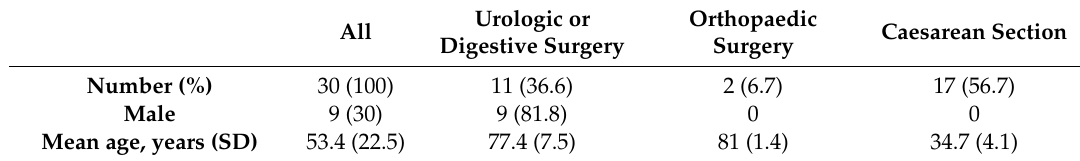
Table 3. Demographic characteristics of the control patients.